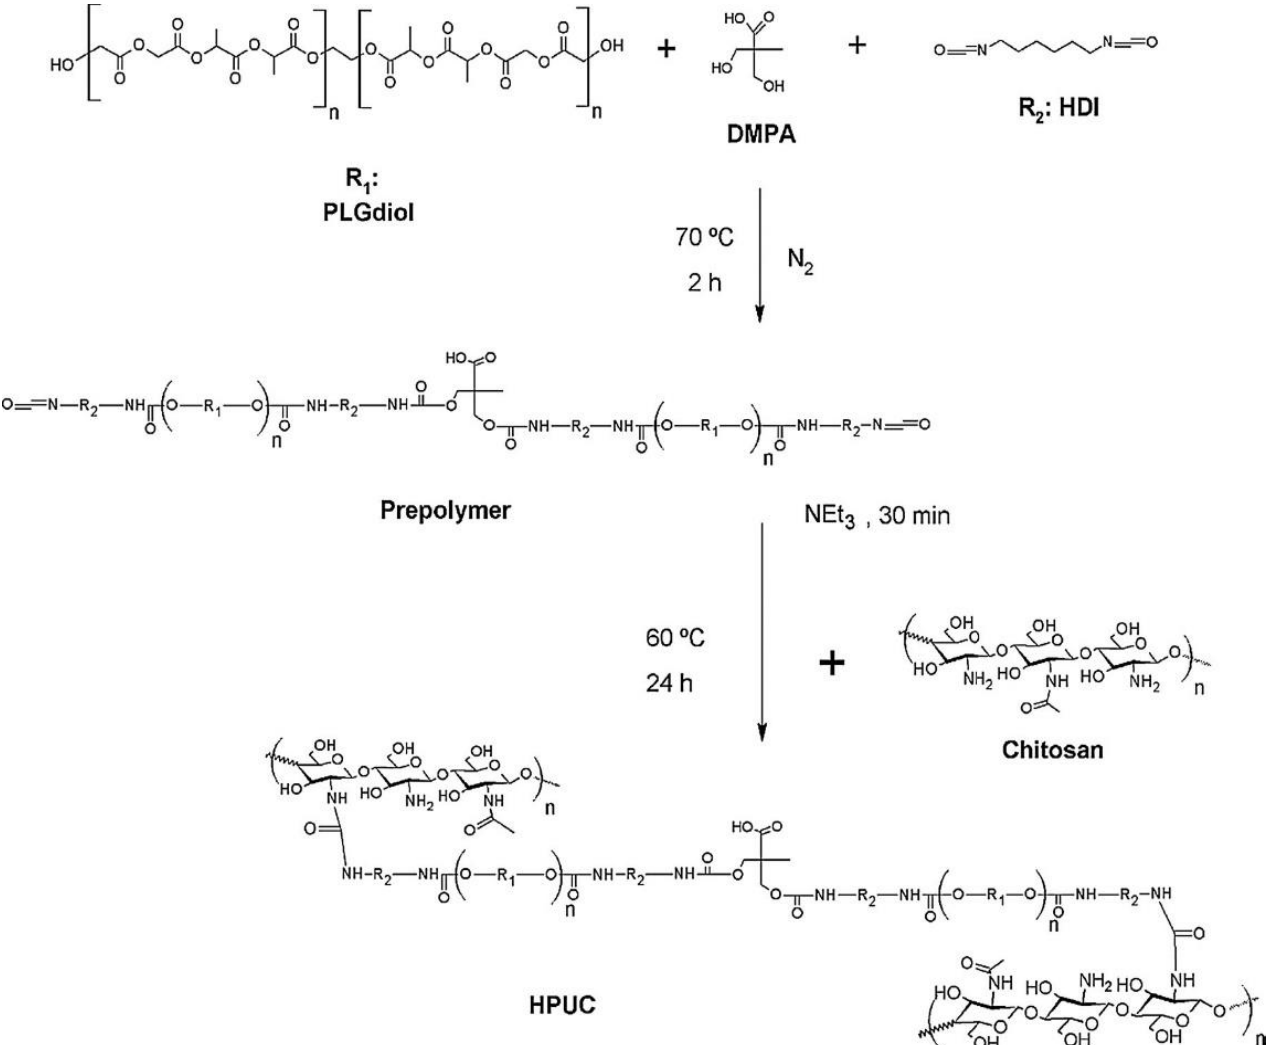
Figure 10. Elementary steps of synthesis of chitosan-polyurethane hydrogel membrane (HPUC) (reproduced with permission from [87]).